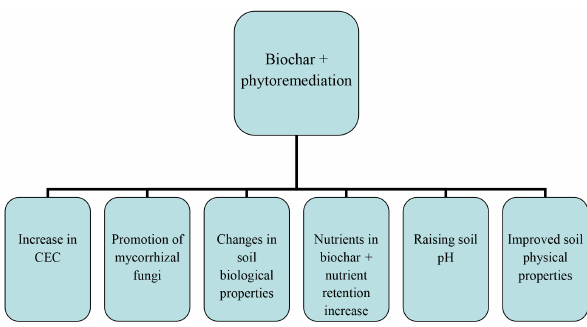
Fig. 1. An overview of the potential positive effects attained by combining phytoremediation and biochar in heavy metal pollution